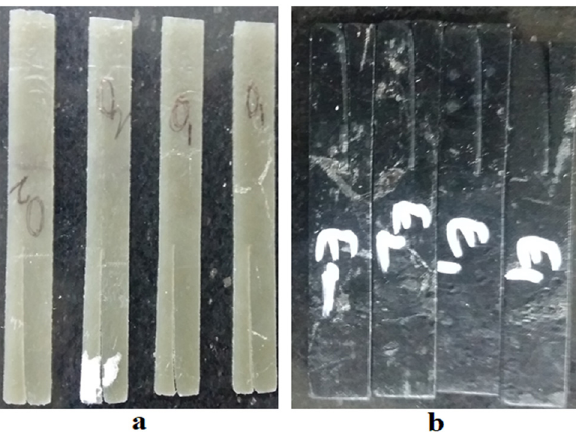
Figure 9: ( a – b ) : Tear - resistance testing